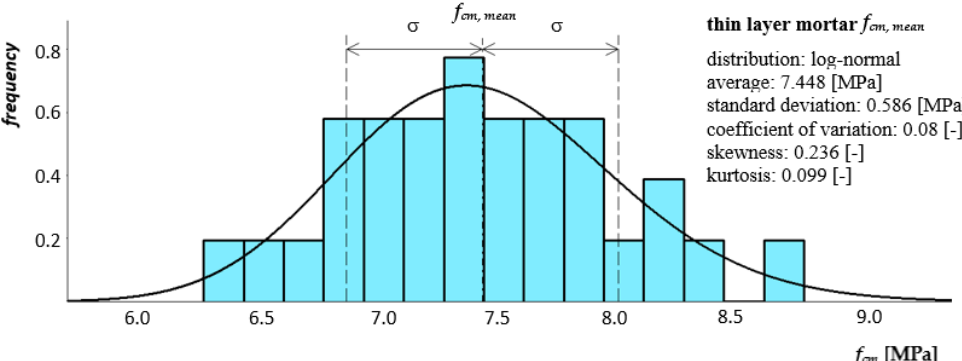
Figure 9. Histogram together with the approximate function of the compressive strength distribution of thin-layer mortar as a component of a masonry wall made of autoclaved aerated concrete blocks.